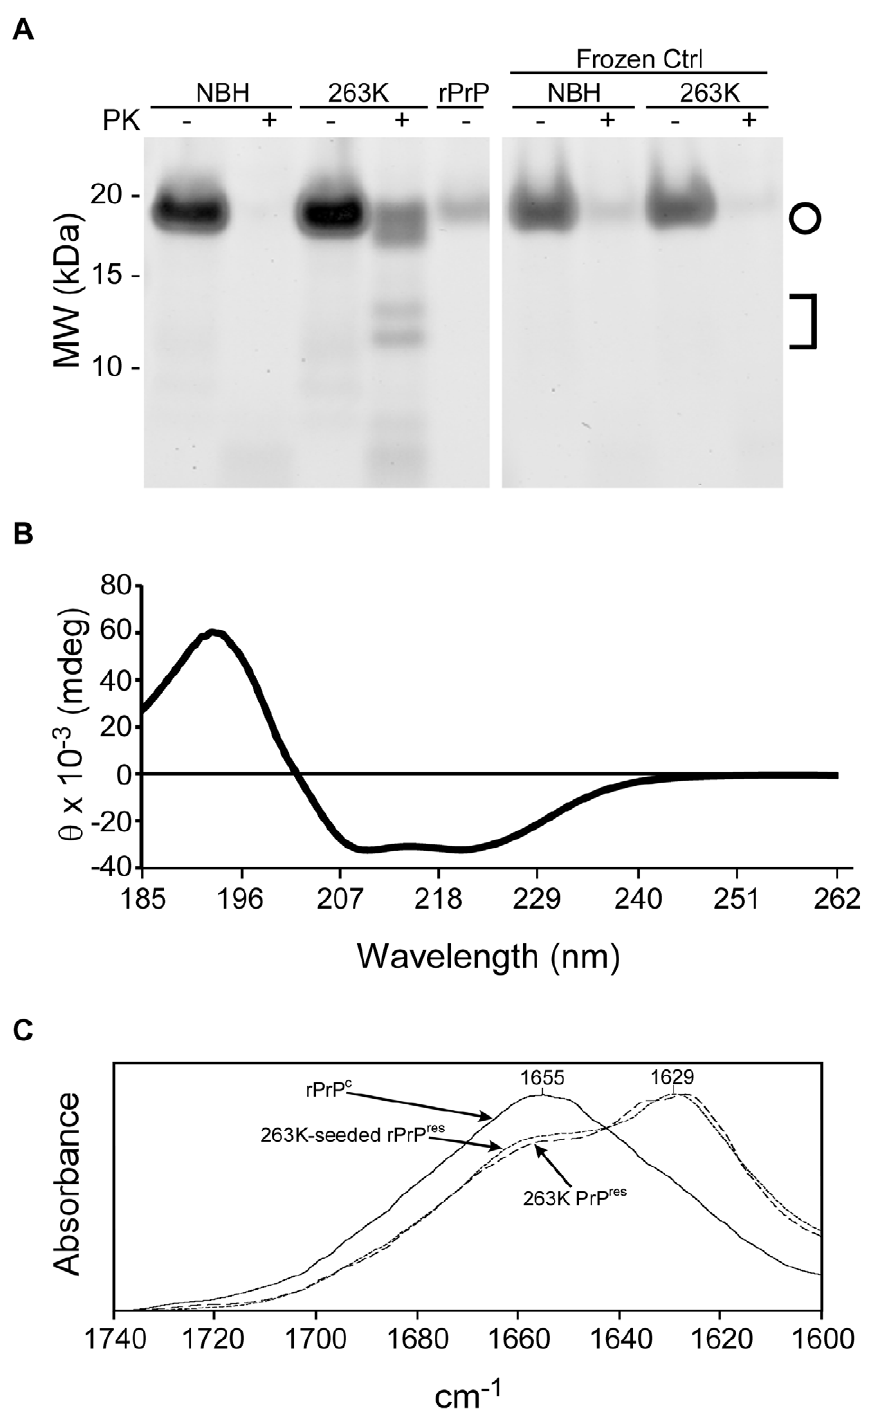
Figure 2. SDS-PAGE, circular dichroism (CD), and Fourier transform infrared spectroscopy analyses of RT-QuIC products. RT-QuIC reactions were seeded with 5 6 10 2 6 dilution of either NBH or 263K BH (containing 100 fg PrP Sc ). (A) Products were PK digested and analyzed by SDS- PAGE. The gel was stained with a non-specific protein stain (Deep Purple). The circle indicates the , 18 and 19 kDa bands while the bracket represents the , 13 and 14 kDa bands in the PK-digested products of the scrapie-seeded reaction. (B) CD spectrum of the initial hamster rPrP C 90-231 substrate for RT-QuIC reactions. (C) FTIR spectra of hamster rPrP C 90-231, 263K-seeded rPrP 90-231 RT-QuIC product, and PK-treated brain-derived 263K PrP Sc .